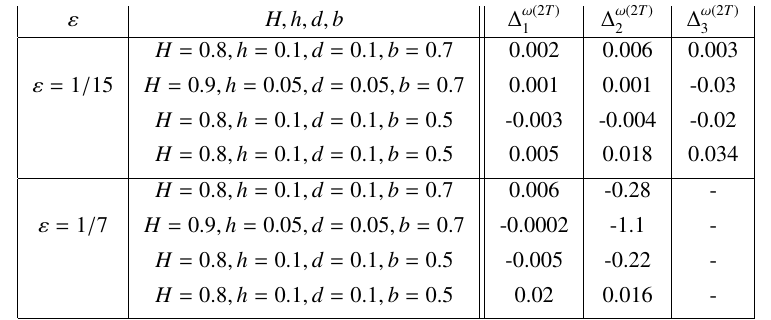
Table 3. Relative di ff erences for homogeneous I-beam, ν = 0 . 25 , E n = E c ε H , h , d , b ∆ ω (2 T )